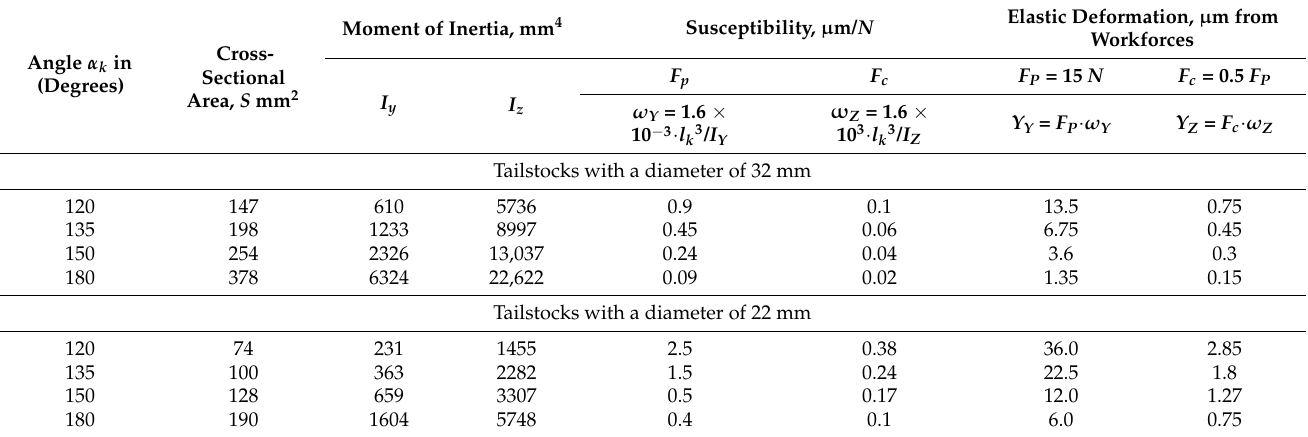
Table 1. Elastic flexibility and deformation of the tailstocks with a weakened section on the extension; l k = 70